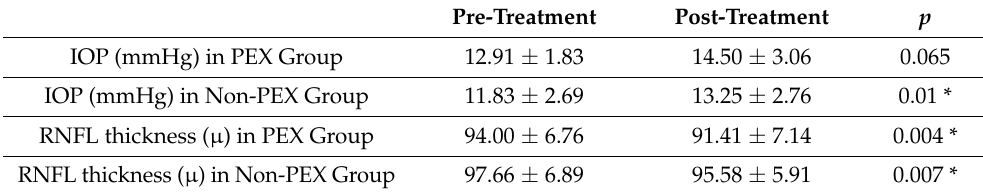
Table 2. Comparisons of pre- and post-treatment IOP and RNFL